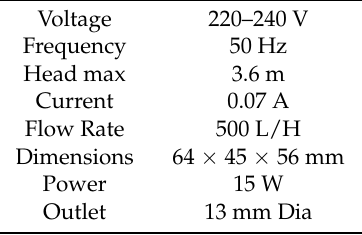
Table 4. Specification of water pump used for